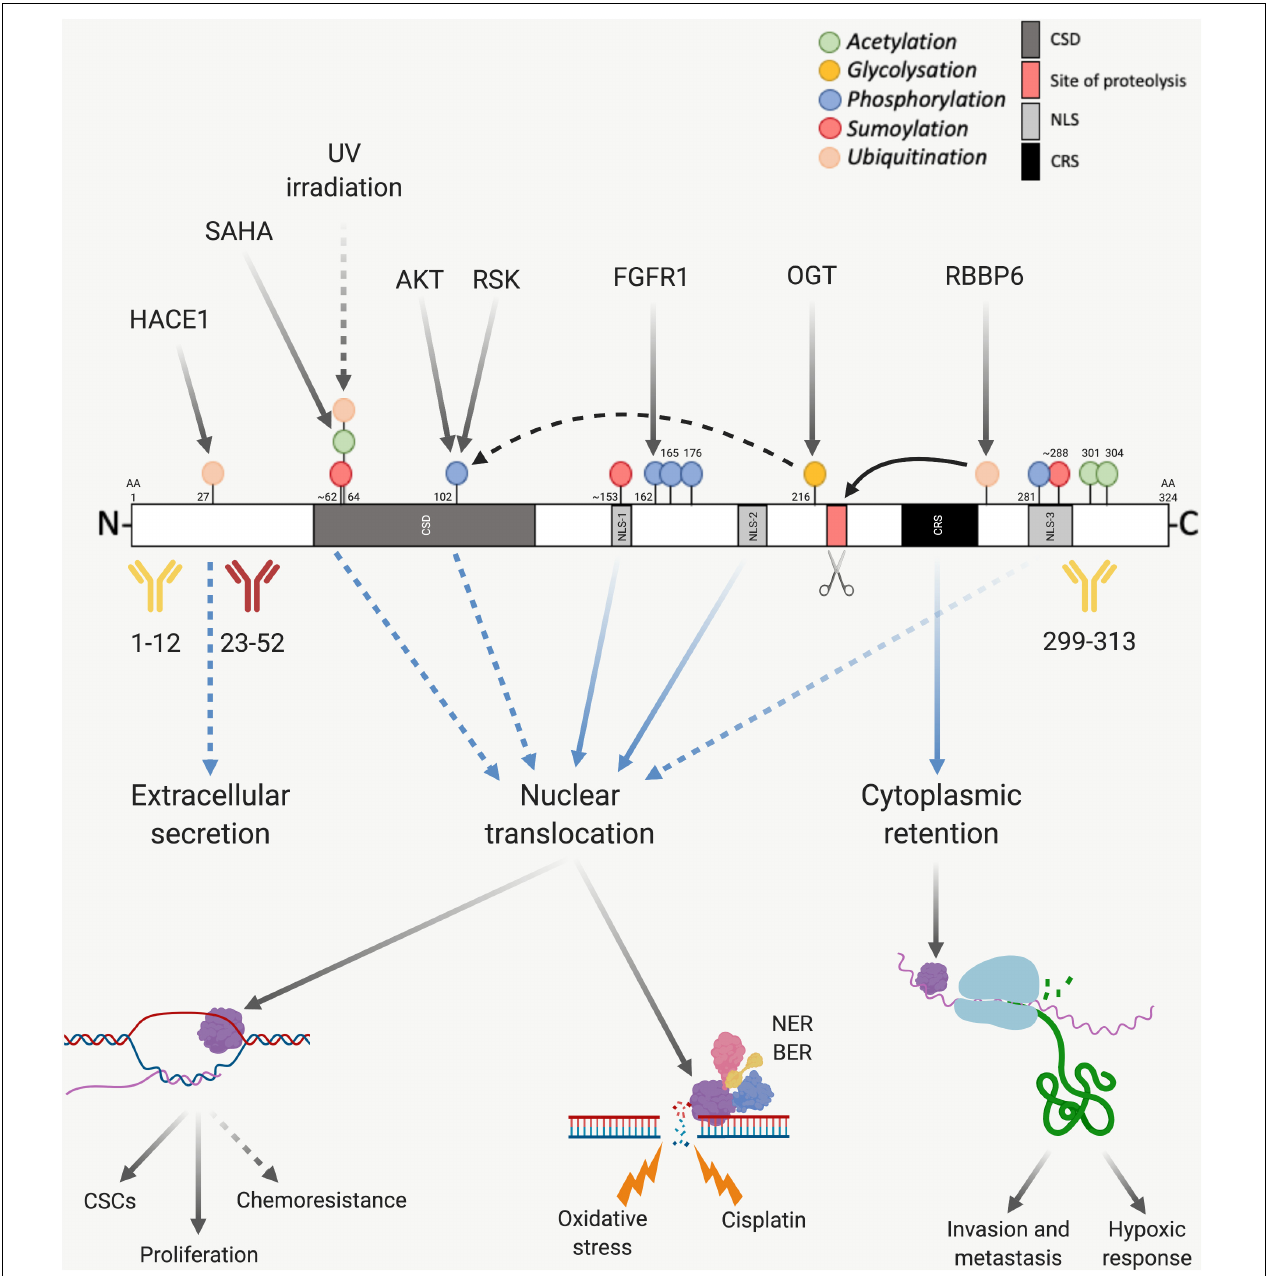
FIGURE 3 | Post-translational modification of YB-1. The presence of various sites before or after proteasomal cleavage of YB-1 modulates its function and localization, which has implications on antibody use. YB-1 is comprised of a CSD shown in dark gray, an N-terminal domain in white and a CTD, also in white. Within the CTD there are three nuclear localization signals (NLS-1 from amino acid (aa) 149–156, NLS-2 from aa 185 to 194 and NLS-3 from aa 276 to 292), shown in light gray, and one cytoplasmic retention signal (CRS from aa 247 to 267), shown in black. YB-1 is proteolytically cleaved at Glu216 and Glu219 (shown in red and highlighted with a scissors icon), which is thought to stimulate YB-1 translocation. Three commonly used antibodies targeting YB-1 are also shown, two of which have been validated using mass spectrometry (in yellow) and one which is known to cross react with hnRNP1A (in red). If the proteolytic theory of YB-1 translocation is correct, this would also have implications on the use of antibodies. Various post-translational modifications also effect the downstream function and nuclear localization of YB-1. Green dots indicate acetylation, yellow glycosylation, blue phosphorylation, red sumoylation and orange ubiquitination. Solid black arrows indicate a post-translational modification that is produced by a known upstream regulator, or a known function of YB-1. Dotted black arrows indicate a post-translational modification or function that is yet to be fully proven. Blue and dotted blue arrows indicate the movement or supposed movement of YB-1 throughout cellular compartments, respectively. Created with